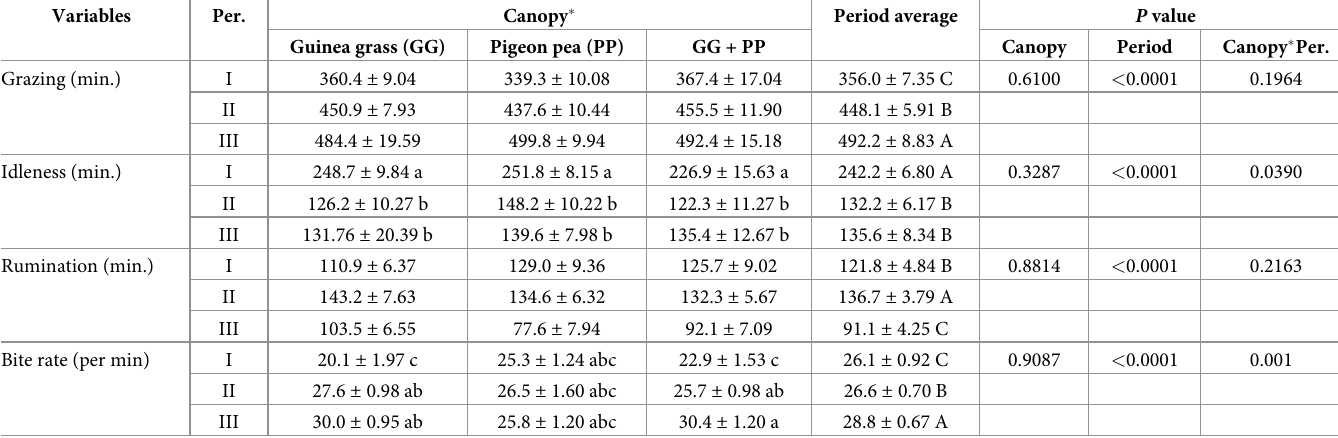
(1347.3 kg DM / ha). Forage allowance was also similar among canopies, with 3.6 kg forage mass/kg LW for GG with stocking rate of 1919 kg LW/ha (4.3 AU/ha); for PP showed 3.5 kg forage mass/kg LW and stocking rate of 1611 kg LW/ha (3.6 AU/ha); and 3.0 kg forage/kg LW for GP with stocking rate of 1708 kg LW/ha (3.8 AU/ha).